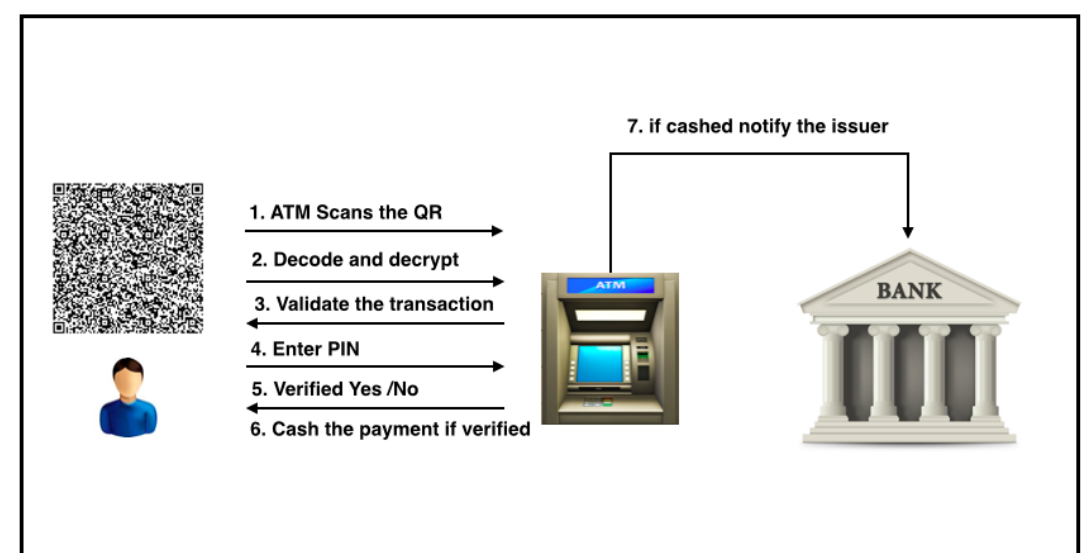
Figure 8. The payment verification phase in QuickCash